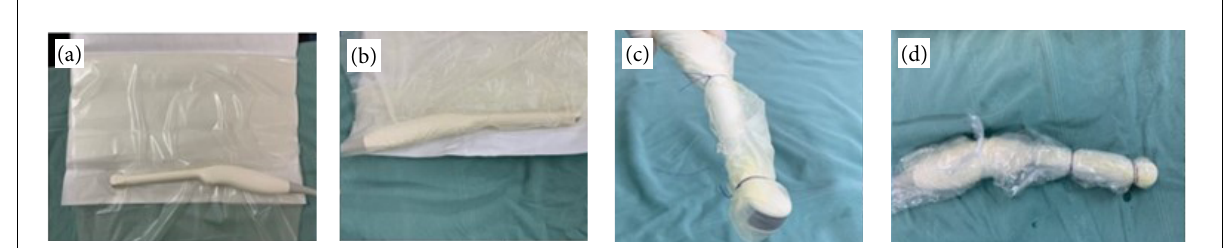
Figure 1 - Preparation of the endocavitary probe.